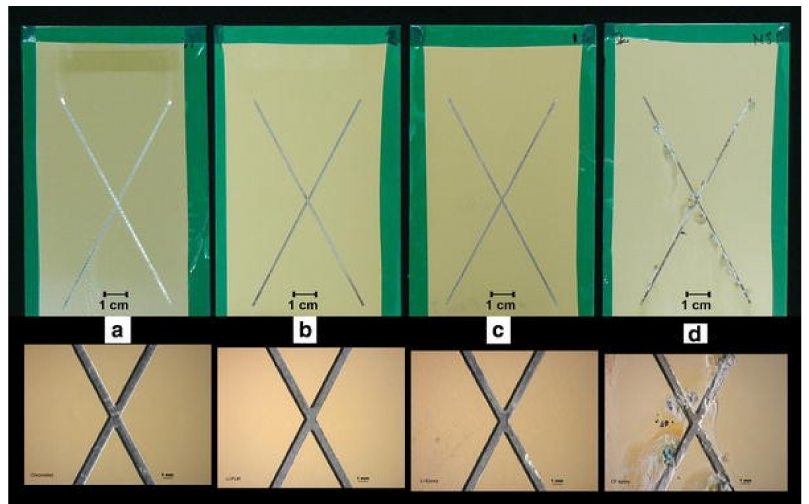
Figure 4. Optical images of AA2024-T3 aluminum alloy coated with industrial coating concepts after 3000 h salt spray exposure (top, entire panel; bottom, increased magnification): ( a ) chromate primer, ( b ) polyurethane-based primer with lithium salt inhibitor technology, ( c ) epoxy-amine-based primer with lithium salt inhibitor technology, and ( d ) a previous generation chromate-free inhibitor technology. Reproduced with permission of Springer Nature